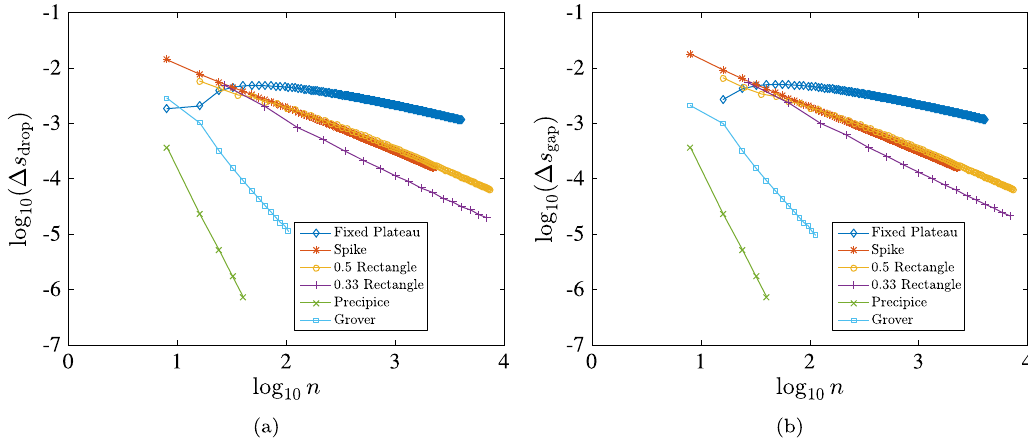
FIG. 3. (a) The difference in the position of the minimum gap from exact diagonalization and the position of the double-well degeneracy [as shown in Fig. 2(a) for the fixed plateau) from the semiclassical potential, as a function of n for the fixed plateau, the spike, the 0.5-rectangle, the 0.33-rectangle, the precipice, and Grover problems (log-log scale). (b) The difference in the position of the sudden drop in Hamming weight [as seen in Fig. 2(c)] and the position of the double-well degeneracy from the semiclassical potential [as seen in Fig. 2(a)], as a function of the number of qubits n for the fixed plateau, the spike, the 0.5-rectangle, the 0.33-rectangle, the precipice, and Grover problems (log-log